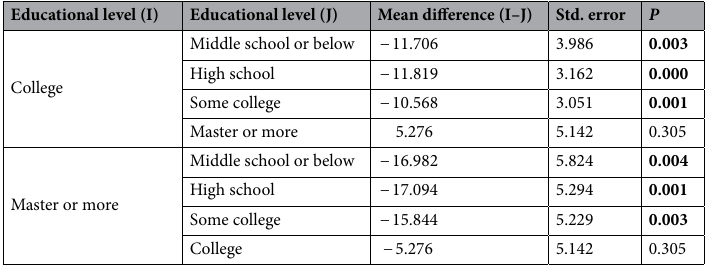
Table 5. Multiple comparisons of FPI scores of men with different education level (N = 508). Significant values are given in bold.